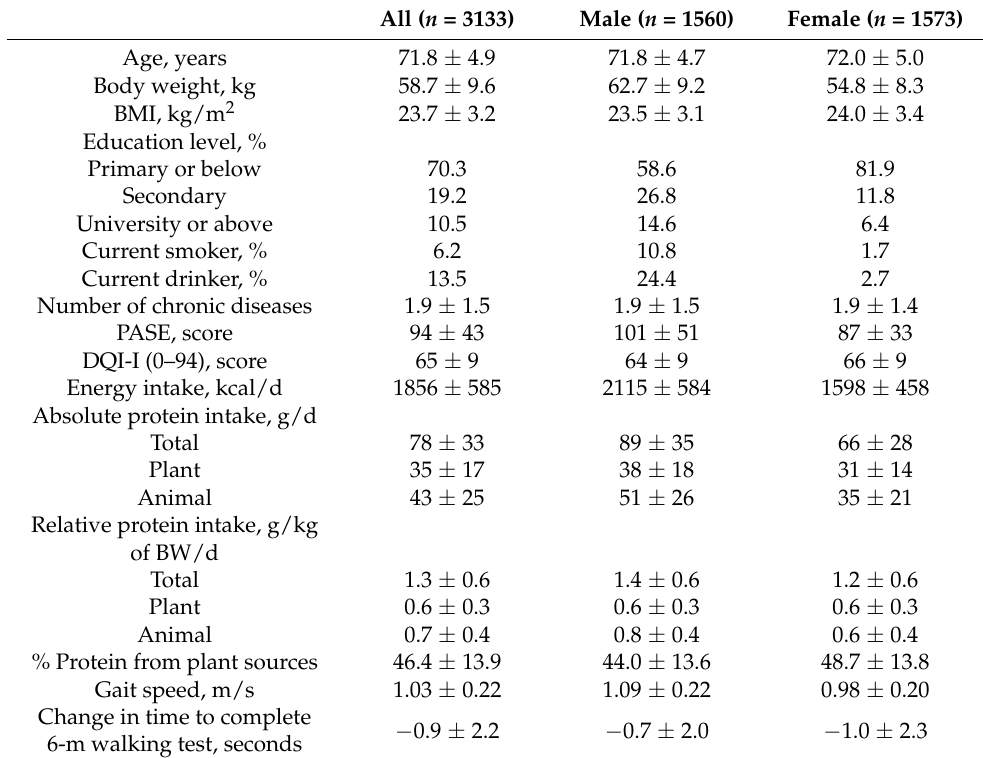
Table 1. Baseline characteristics and 4-year change in physical performance of